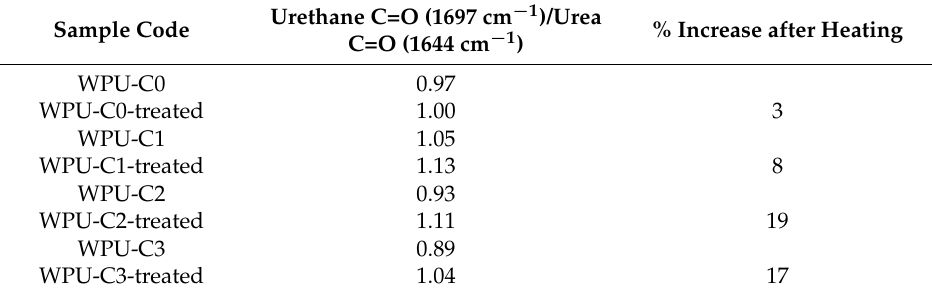
Figure 2. The FT-IR spectra of PU films before and after heat treatment for 24 h at 110 ◦ C. Table 2. The absorbance ratio of the urethane (C=O peak) to urea (C=O peak) in an untreated and treated sample of WPU.